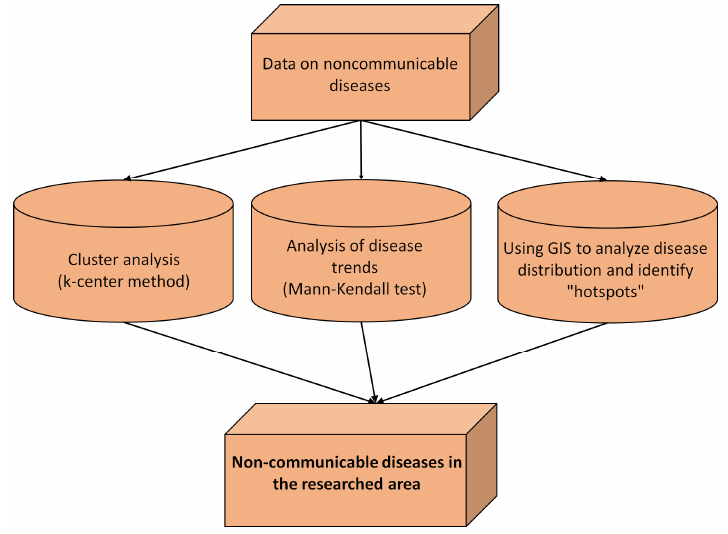
Figure 2. The process from the data collection to the analysis and the research results.